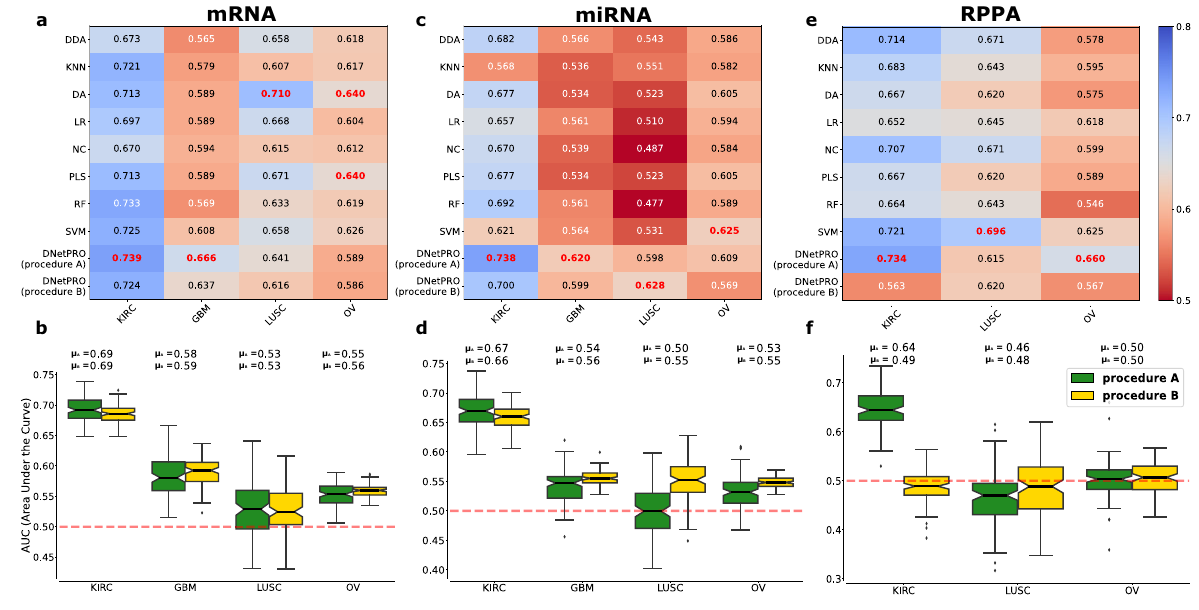
Figure 4. Results obtained by the DNetPRO on the mRNA, miRNA, and RPPA samples related to the four cancer types in the Synapse dataset. Methods legend: DDA diagonal discriminant analysis, KNN K-nearest neighbor, DA discriminant analysis, LR logistic regression, NC nearest centroid, PLS partial least squares, RF random forest, SVM support vector machine. ( a,c,e ) Comparison of the DNetPRO results with the methods used in the work of Yuan et al., in terms of the maximum AUC value obtained on a ten-fold cross-validation procedure (bold red: top-performing method). In procedure A , the maximum AUC was estimated as the maximum score value obtained by each extracted signature on the related test set of the ten-fold subdivision. In procedure B , the maximum AUC was estimated as the maximum score value obtained by the best signature obtained by the ten-fold cross-validation on the related validation set. ( b,d,f ) Distributions of the AUC values related to each analyzed dataset. Green boxplots: results using procedure A as described in Fig. 2; yellow boxplots: results using procedure B . The results obtained by the two procedures are not directly comparable due to the different data subdivisions and therefore the two distributions are plotted Synapse dataset. Four omics dataset were extracted from TCGA (The Cancer Genome Atlas) and made available at the Synapse homepage created by Yuan et al. 20 (syn30 0013, doi: 10. 7303/ syn30 0013): kidney renal clear cell carcinoma (KIRC), glioblastoma multiforme (GBM), ovarian serous cystadenocarcinoma (OV) and lung squamous cell carcinoma (LUSC) (see “Materials and methods” and Supplementary Materials for further details). For each cancer type, we analyzed the mRNA, miRNA, and RPPA (protein) datasets, performing the clas- sification of dichotomized survival outcomes 20 via the same train/test subdivisions provided by Yuan et al. We intentionally did not include the set of clinical information related to each cancer type (and available in the online repository), since the focus of our work is not on the best classification performances for the involved tumor, but only on the possibility of using this approach to omics feature selection on high throughput data. As already showed in the work of Yuan et al., we could surmise that extending the analysis to other types of information (clinical, demographical or other) could improve the overall classification performance. We report the results in terms of maximum AUC (ref. Fig. 4a,c,e) and AUC distributions (ref. Fig. 4b,d,f) in order to be comparable with the results reported by the algorithms used in the work of Yuan et al. We show the results obtained with the procedure A of DNetPRO (corresponding to the validation approach used by Yuan et al.) and procedure B (full double cross-validation procedure to avoid data contamination) in comparison with a series of more complex methods based on single-feature evaluations as proposed by Yuan et al. The results on the mRNA datasets using procedure A are comparable (LUSC) or better (KIRC, GBM) than the results reported in Ref. 20 , except for the OV dataset. This ranking is maintained even with the more conservative procedure B , involving a further cross-validation step. The size of the extracted signatures is approximately con- stant between cross-validations, and typically smaller than 500 genes in each pipeline execution. Performances decrease with the introduction of the second cross validation step (procedure B ), as expected, but they remain quite stable, showing the robustness of the extracted signatures. We remark that the validation procedure used by Yuan et al. corresponds to our approach without the second validation step (procedure A ). The results obtained on the miRNA datasets are comparable to the reference ones, while for the RPPA datasets only the LUSC shows AUC values comparable with the others. Moving from procedure A to procedure B , i.e., adding a second cross- validation step, RPPA performances drastically decrease for the KIRC and OV, while they remain stable for the LUSC dataset. The same behavior is shown in the miRNA datasets, in which however both performances are still comparable or better (KIRC, GBM, LUSC) than the reference ones.